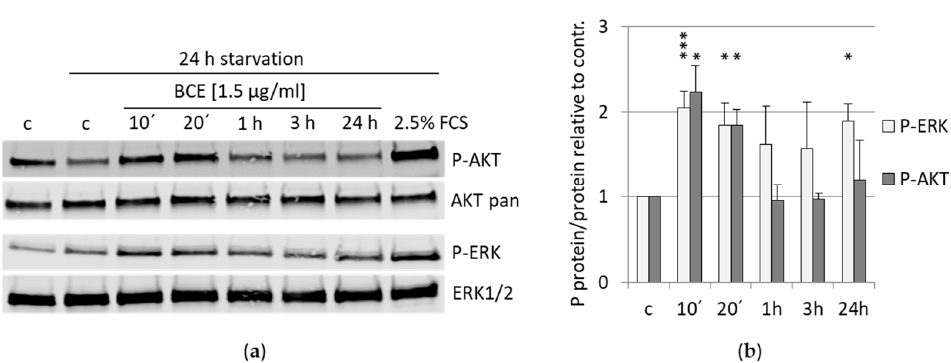
Figure 8. BCE induces phosphorylation of AKT and ERK kinase in EA.hy926 cells. ( a ) EA.hy926 cells were starved for 24 h (reduction of serum concentration in the cell culture medium in order to synchronize the cells) or maintained in normal medium followed by BCE treatment for indicated times. Cells incubated with 2.5% FCS for 20 min served as an induction control. Phosphorylation of AKTs at Serine 473 and phosphorylation of ERK1/2 at Threonine 202/Tyrosine 204 was determined by normalization to total AKT protein or total ERK1/2 protein, respectively. One representative Western blot of four independent experiments with EA.hy926 cells is shown. ( b ) Quantification of phosphorylated proteins vs. total non-phosphorylated proteins relative to control (under starvation). The data were presented as mean values with standard deviation from four independent experiments. * p < 0.05; *** p < 0.001 ( t -test) BCE-treated vs. control sample.